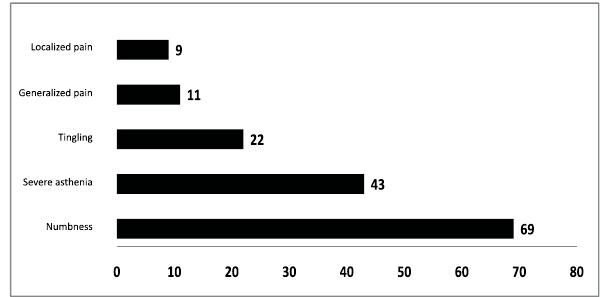
Fig 3. Late neurological manifestations of snake